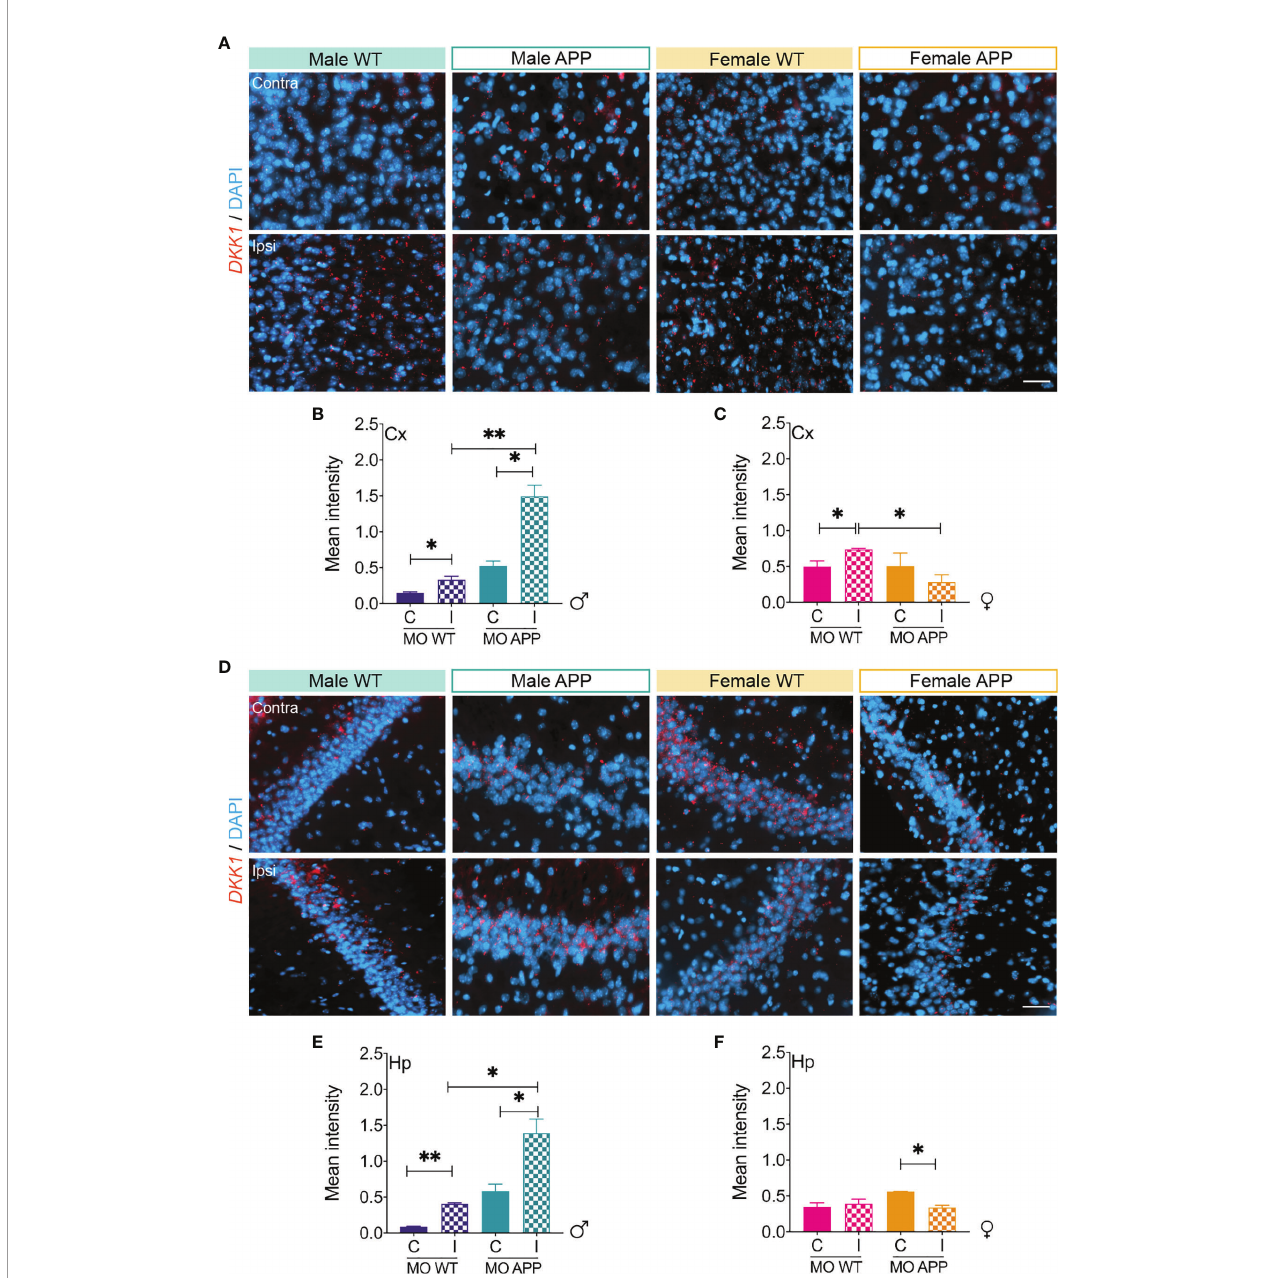
FIGURE 10 | DKK1 expression is increased in response to microinfarction dependently upon biological sex. (A) Representative images of FISH assay showing DKK1 mRNA transcripts (red) and DAPI (blue) in the contralateral and ipsilateral cortex of MO-operated male and female WT and APP/PS1 mice. (B) Analysis of the fl uorescence intensity indicates that the expression of DKK1 mRNA is slightly increased in the ipsilateral cortex of MO-operated male WT mice, which is more pronounced in the ipsilateral cortex of MO-operated male APP/PS1 mice. (C) Analysis of the fl uorescence intensity indicates that the expression of DKK1 mRNA is slightly increased in the ipsilateral cortex of MO-operated female WT mice, while it is deceased in the ipsilateral cortex of MO-operated APP/PS1 mice compared to MO-operated WT animals. (D) Representative images of FISH assay showing DKK1 mRNA transcripts (red) and DAPI (blue) in the contralateral and ipsilateral hippocampus of MO-operated male and female WT and APP/PS1 mice. (E) Analysis of the fl uorescence intensity indicates that the expression of DKK1 mRNA is slightly increased in the ipsilateral cortex of MO-operated male WT mice, which similarly to the cortex is more pronounced in the ipsilateral cortex of MO-operated male APP/PS1 mice. (F) Analysis of the fl uorescence intensity indicates that the expression of DKK1 mRNA remains unchanged in the ipsilateral hippocampus of MO-operated female WT mice, while it tends to decrease in the hippocampus of MO-operated female APP/PS1 mice. Data are mean ± SEM (n = 5-10 animals/group). C, Contralateral; I, Ipsilateral. *P < 0.05/ **P < 0.01 compared with sham- and MO-operated WT or APP/PS1 mice (two-tailed unpaired t-test). Scale bar = 50